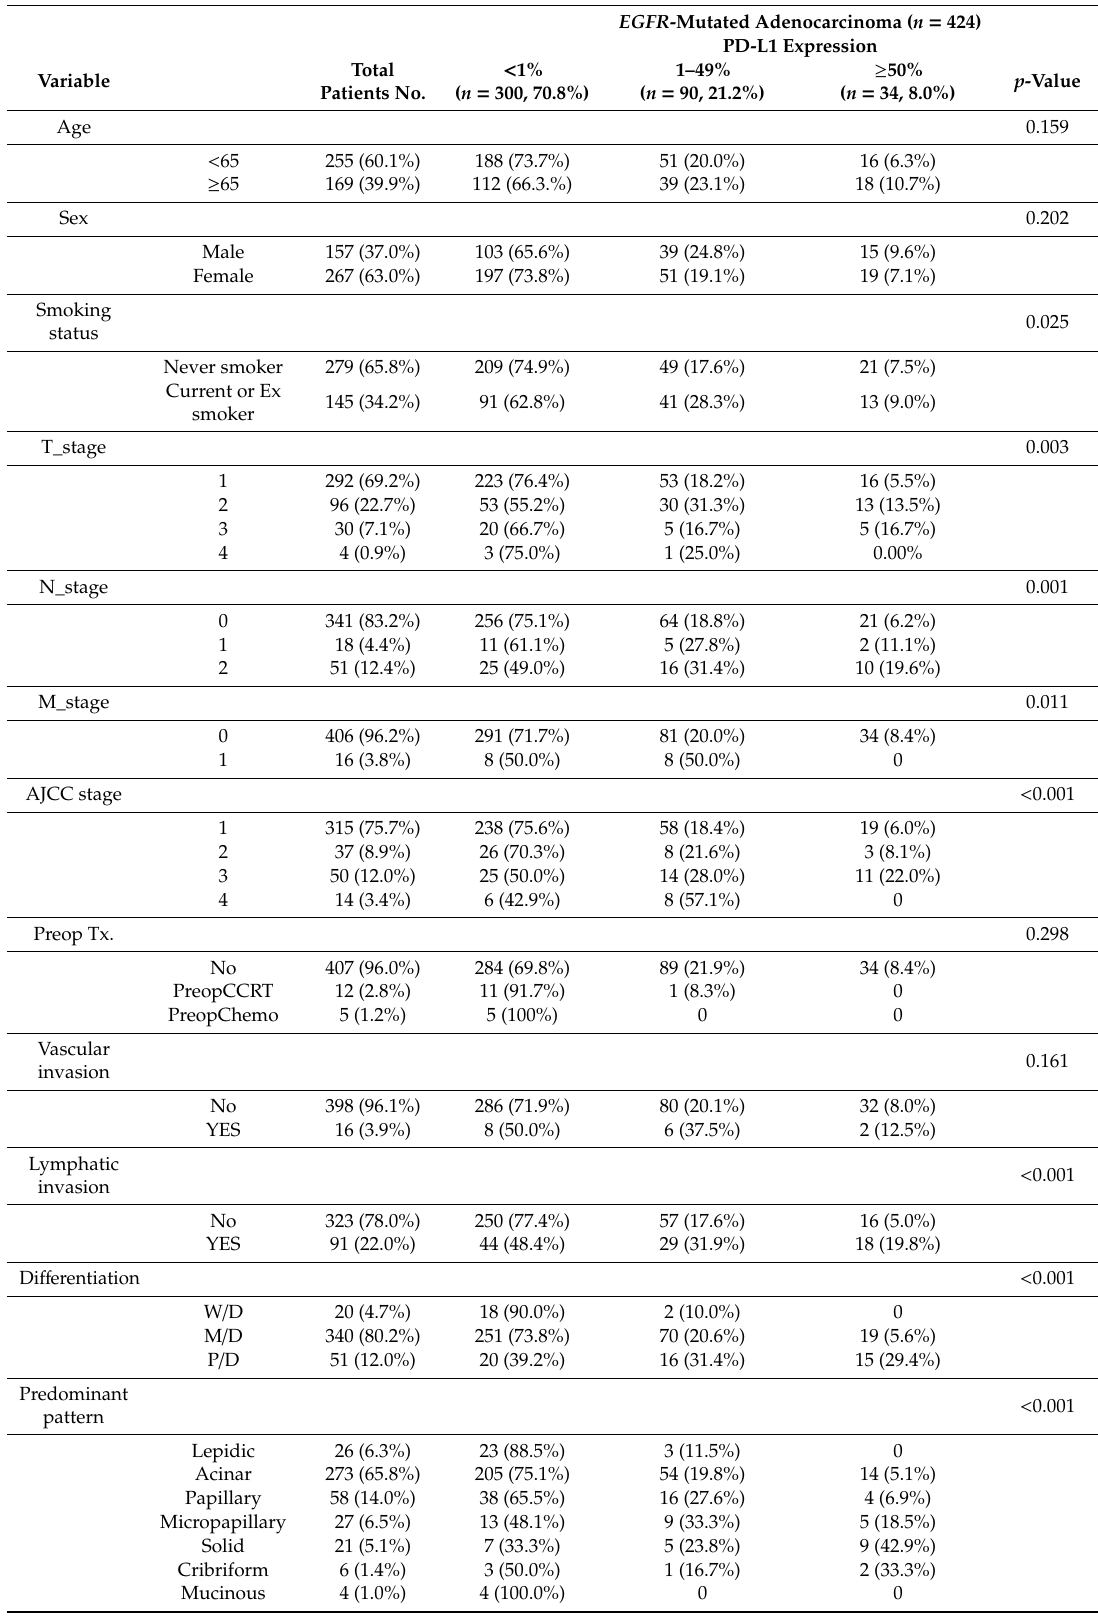
Table 4. Association between PD-L1 expression status and clinicopathological features in 424 EGFR mutated lung